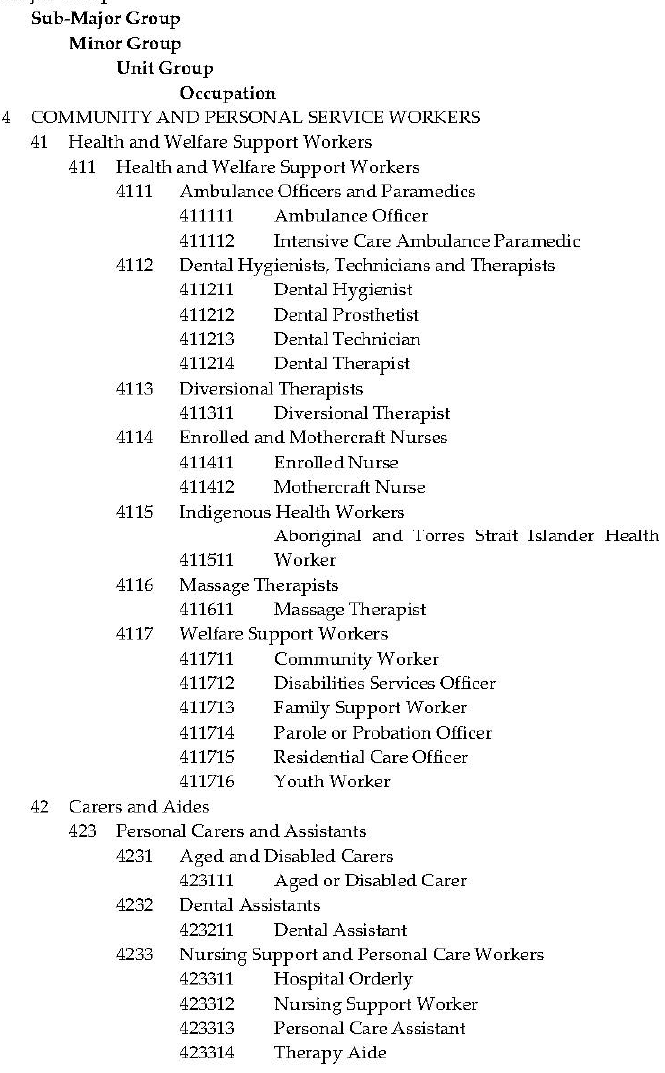
Figure 1. Extract from ANZSCO, Version 1.2.